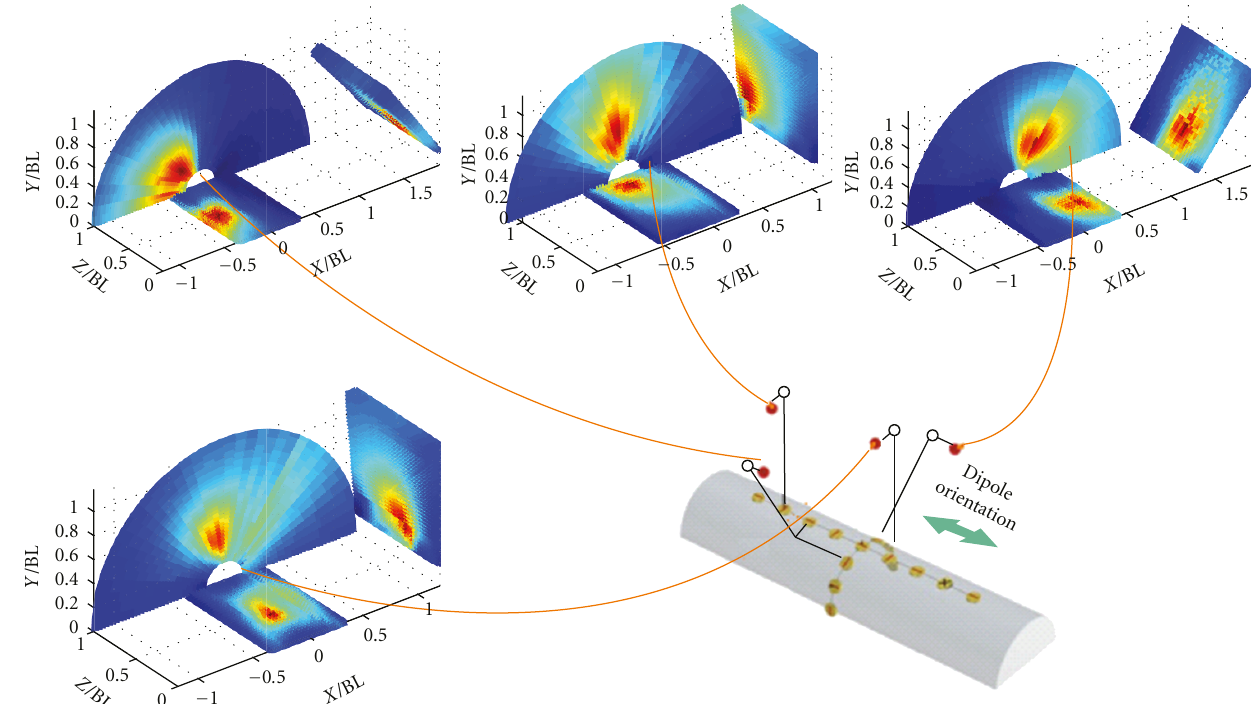
Figure 5: More results of dipole imaging for di ff erent locations showing by cutting through the center of the 3D images along the cylinder, across the cylinder, and along the curved surface of the cylinder. The actual dipole locations are represented by black open circles while the estimated locations are indicated by solid